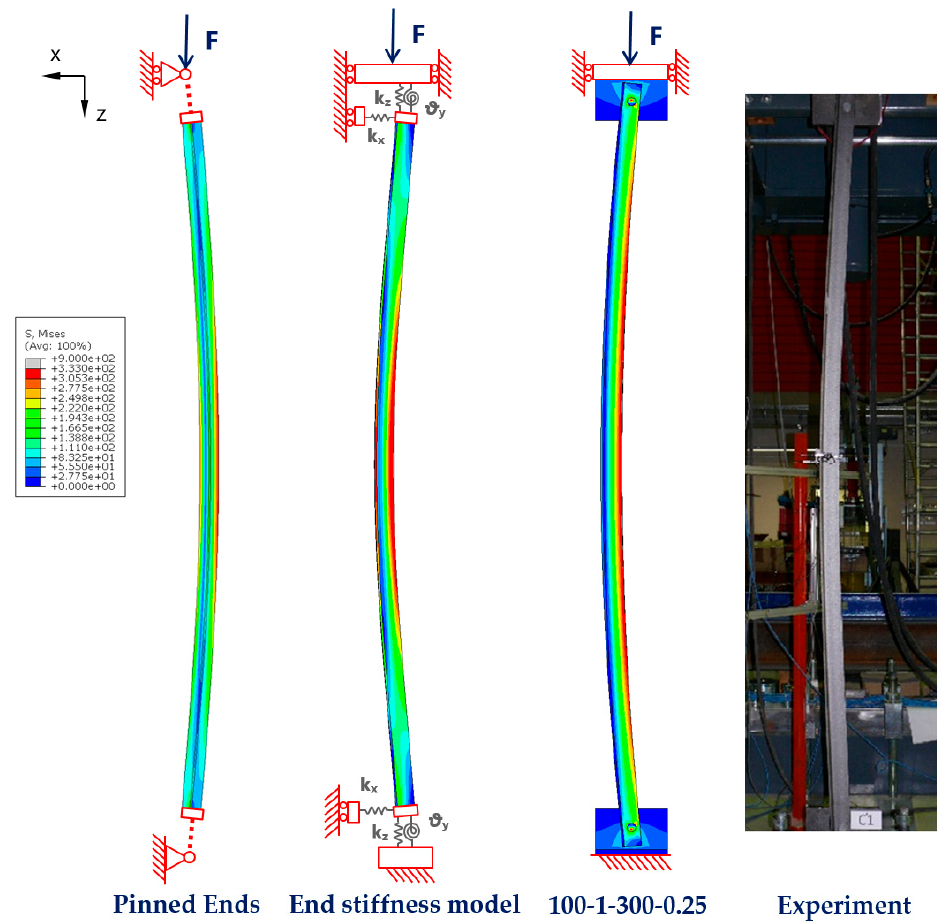
Figure 10. Comparison of the deformed models upon ultimate capacity load. From left to right: the pinned model, the compliant joint model (with the fictitious linear and rotational springs to symbolize the wire connector elements), the FE reference (100-1-300-0.25) and the real counterpart from [10]. Notice how no part of the brace section is yielding, a sign that the failure mode is elastic buckling. Table 4. Load capacity of the models